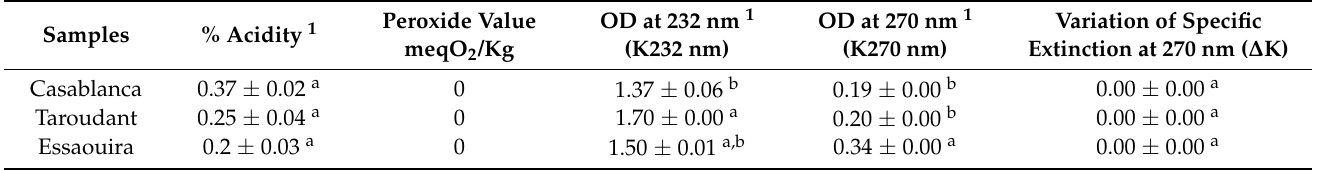
Table 1. Comparison of physico-chemical parameters of argan oil from a plantation (Casablanca) and two natural forest stands (Taroudant and Essaouira) of argan trees.